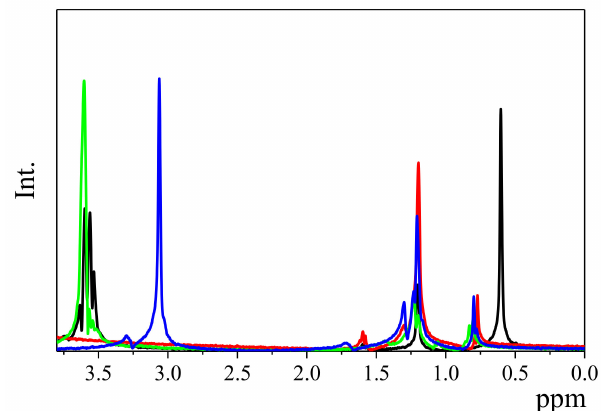
Figure 4. 1 H NMR spectra of various surfactants in aqueous CaCO 3 particle suspensions. Triton X-100 (black), SDS (red), Softanol-70 (green), and CTAB (blue) were used as surfactants. All of the spectra were obtained using the PFGSTE pulse sequence at a gradient strength of 65 G cm − 1